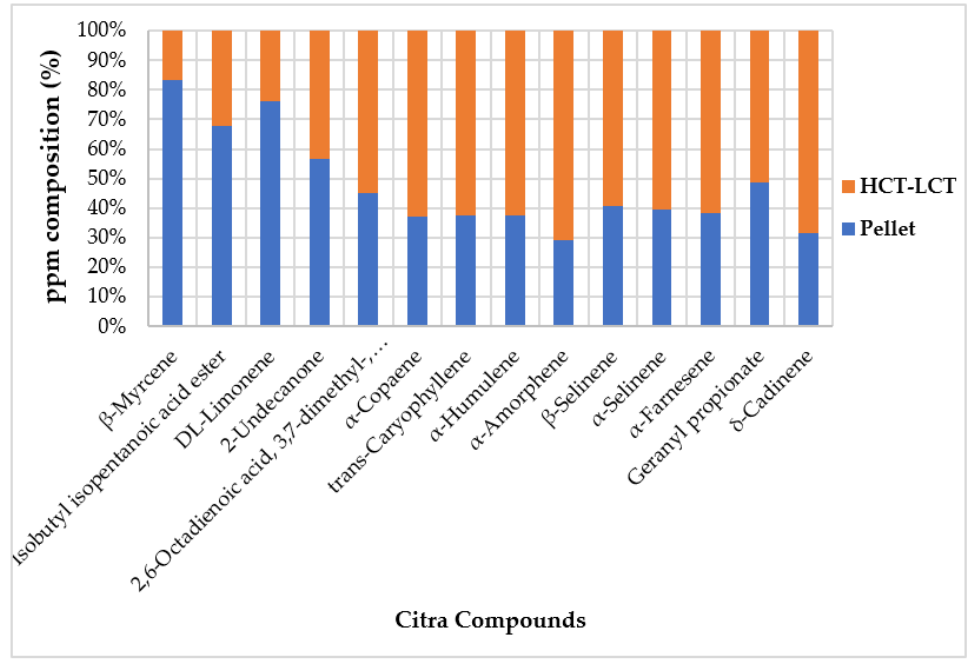
Figure 7. Comparison of the percentage area peaks of the data recovered from the Citra pellets and the weighted average of the HCT and LCT samples. the weighted average of the HCT and LCT